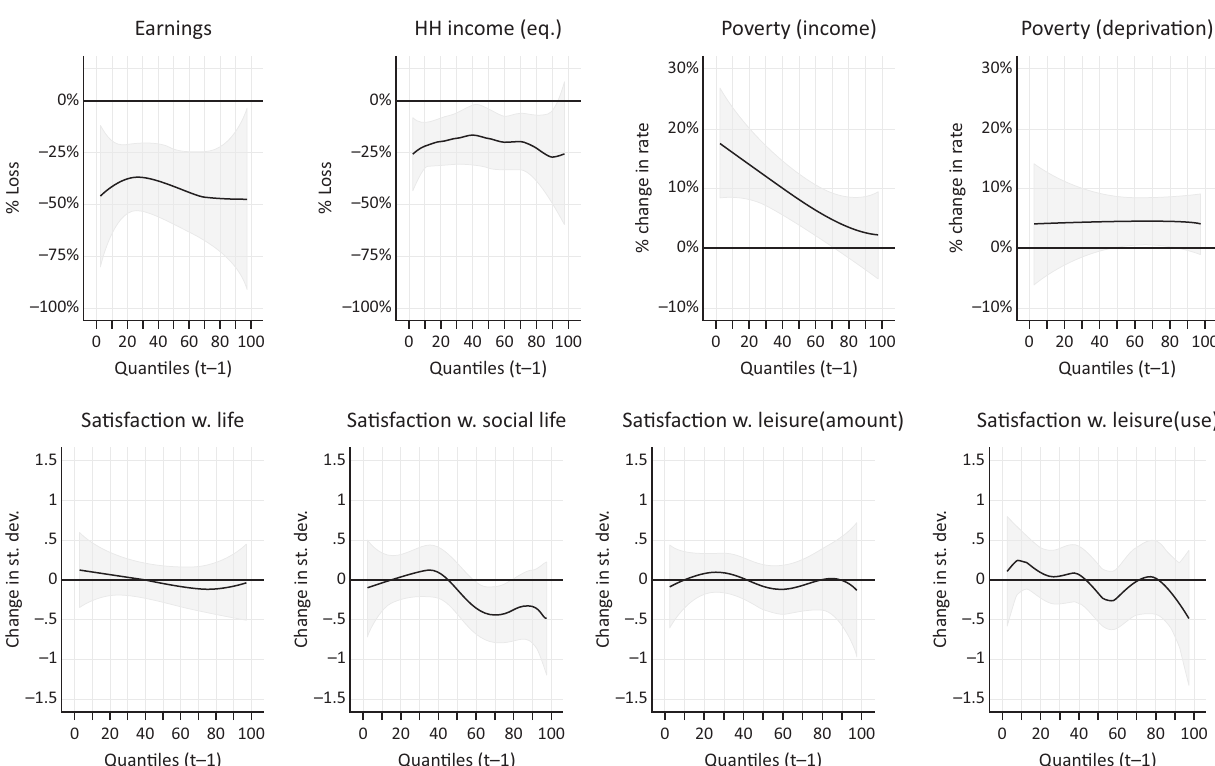
Figure 3. Outcomes in the year of job loss among owners across the distribution. Notes: The graphs show changes in dif‐ ferent outcomes in the year of job loss and how this effect varies across the distribution of home value; quantiles are constructed based on home value in the year before the job loss. Results for income variables show percentage losses, poverty variables show increases in the risk of poverty, and satisfaction variables show changes in standard deviation; the estimates are based on a smooth‐varying coefficient model proposed by Rios‐Avila (2020), a semiparametric kernel regres‐ sion, where the effect of job loss varies as a “smooth” function of quantiles; the shape of the function is estimated using multiple thresholds (i.e., 20) and certain bandwidths, which are optimally estimated by the program (using vc_pack Stata package by Rios‐Avila, 2020); the shaded areas show a 95% confidence interval of estimates; the models include other risk events such as partnership dissolution and number of children as controls; outcomes are residualized for year, age and gender; for definitions of outcomes see Section